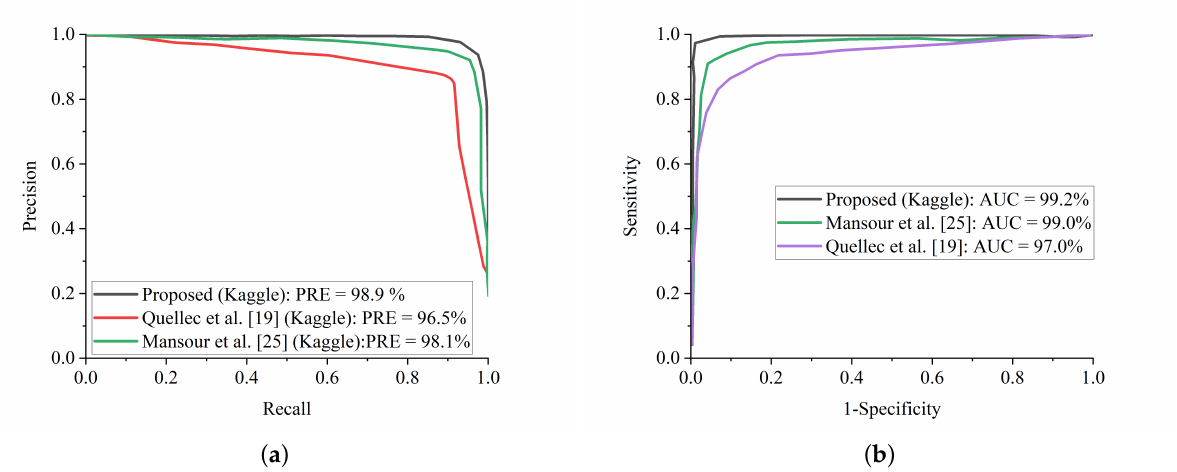
Figure 15. Comparison report of our model with some selected state-of-the-art methods on the Kaggle dataset. ( a ) Precision-recall curve for our proposed model in comparison with some selected state-of-the-art methods on the Kaggle dataset. ( b ) ROC curve for our proposed model in comparison with some selected state-of-the-art methods on the Kaggle